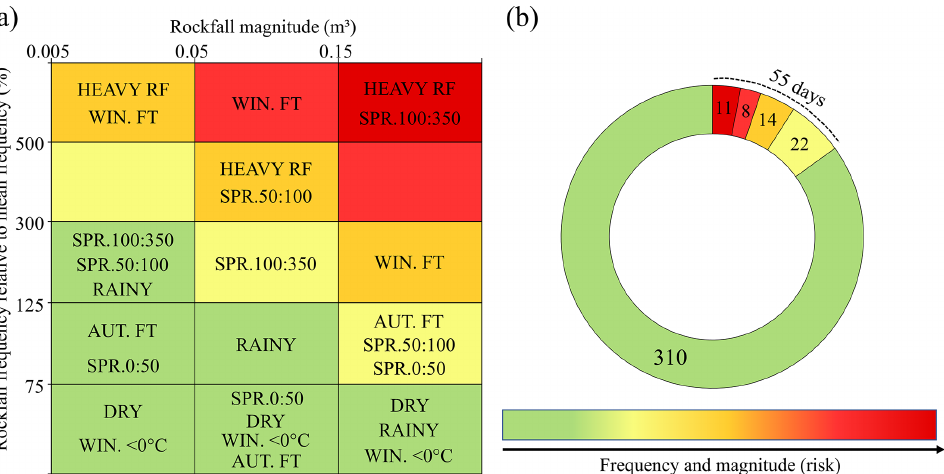
Figure 10. Hazard assessment matrix showing the relationship between rockfall magnitude and frequency for specific weather conditions (a) and cumulative daily occurrence of those conditions during the first complete year of this study (14 June 2019 to 13 June 2020) (b)